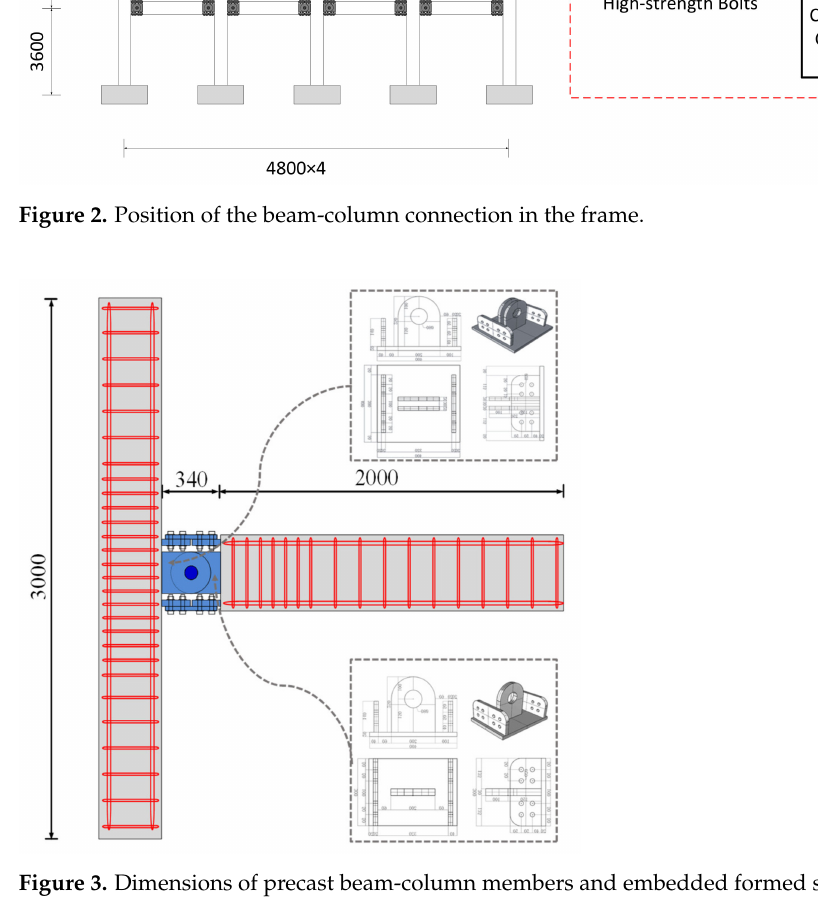
Figure 3. Dimensions of precast beam-column members and embedded formed steel.